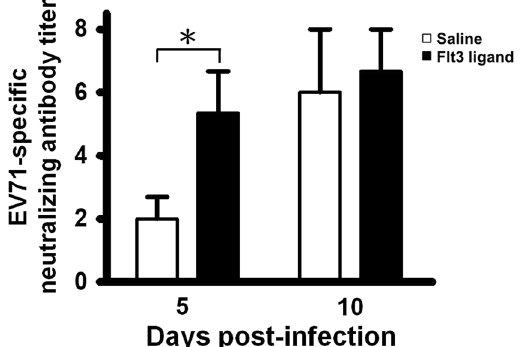
Figure 4. Flt3 ligand pretreatment increases the production of virus-specific antibodies with neutralizing activity in infected mice. Titers of neutralizing antibody titers in sera of infected mice pretreated with saline or Flt3 ligand are shown. Data represent means ± SEs of 3–10 samples per group. * P ≤